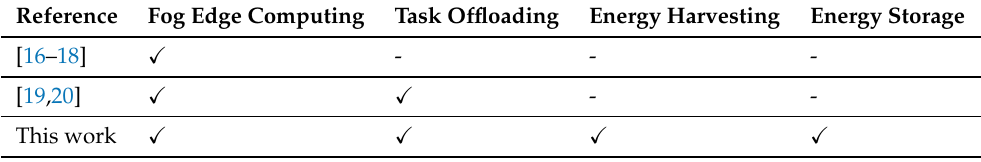
Table 1. Comparison between state-of-the-art surveys. Reference Fog Edge Computing Task Offloading Energy Harvesting Energy